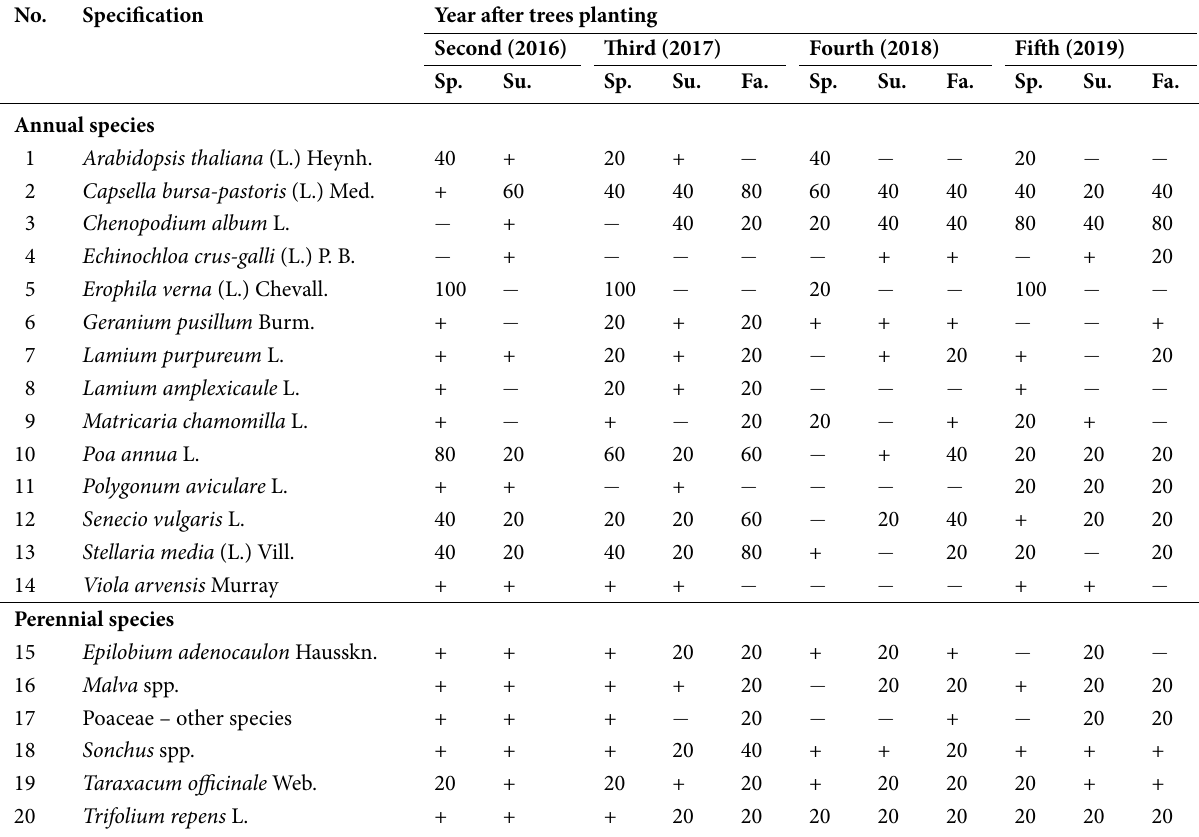
Table 2 Changes in the mean percentage soil surface under coverage of different weed species in tree rows of herbicide fallow plots in the years 2016 to